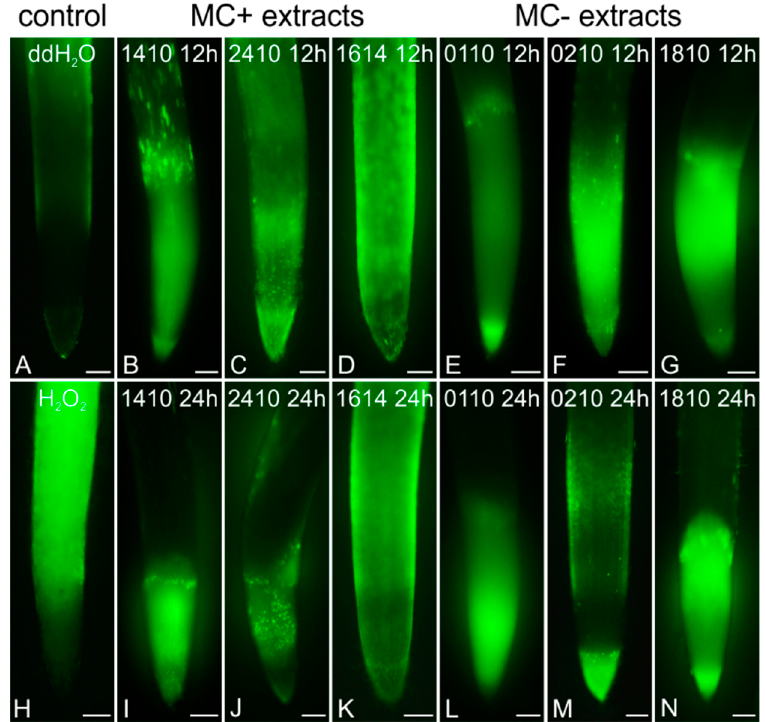
Figure 13. Imaging of H 2 O 2 levels in root tips of Oryza sativa , after staining with 2,7-dichlorofluorescein diacetate (DCF-DA) of control ( A , H ) and extract-treated roots ( B – G , I – N ). Negative control roots were treated with double-distilled water (ddH 2 O 2 , A ) for 24 h, while positive control roots were exposed to an aqueous solution of 10 mM H 2 O 2 for 1 h ( H ). For extract-treated roots, strain codes and treatment durations are indicated on each image. Treatment with MC + extracts (from MC-producing strains) for 12 h ( B – D ) and 24 h ( I – K ) led to increased concentrations of H 2 O 2 in the root meristematic zone. Similar e ff ects were also observed after 12 h ( E – G ) and 24 h ( L – N ) of treatment with MC − extracts from certain non-MC-producing strains (0110, 0210, 1810). Scale bars: 200 µ